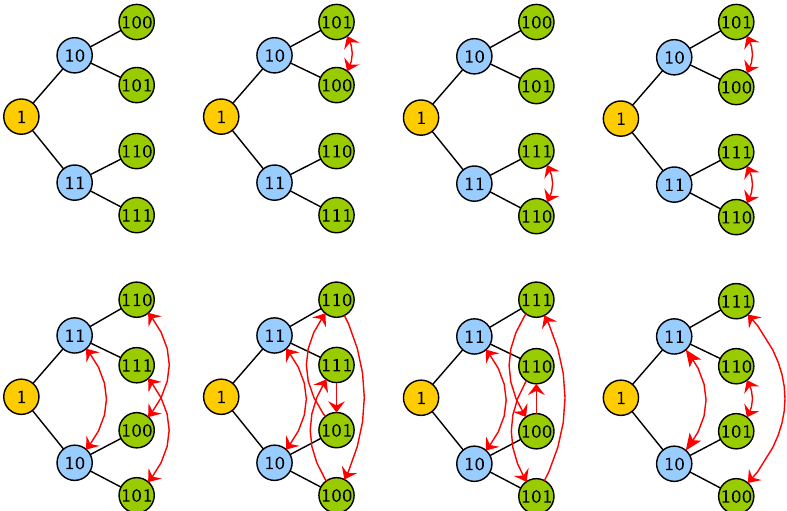
Fig 4. Permutation symmetry of a tree. Here the 8 allowed permutations of a tree with 3 generations are shown. These permutations, which involve the swapping of labels starting from the original arrangement in the top left corner, are allowed because they do not change the relationships in the tree. For example, consider the swapping of labels between sisters 101 and 100 (second from left in top row). Despite the swap, those lineal positions still have the same sister and mother. After any of the 8 permutations shown here, every lineal position still has the same mother, sister, cousins, granddaughters etc. In other words, the lineage tree relationships are invariant to this set of permutations.